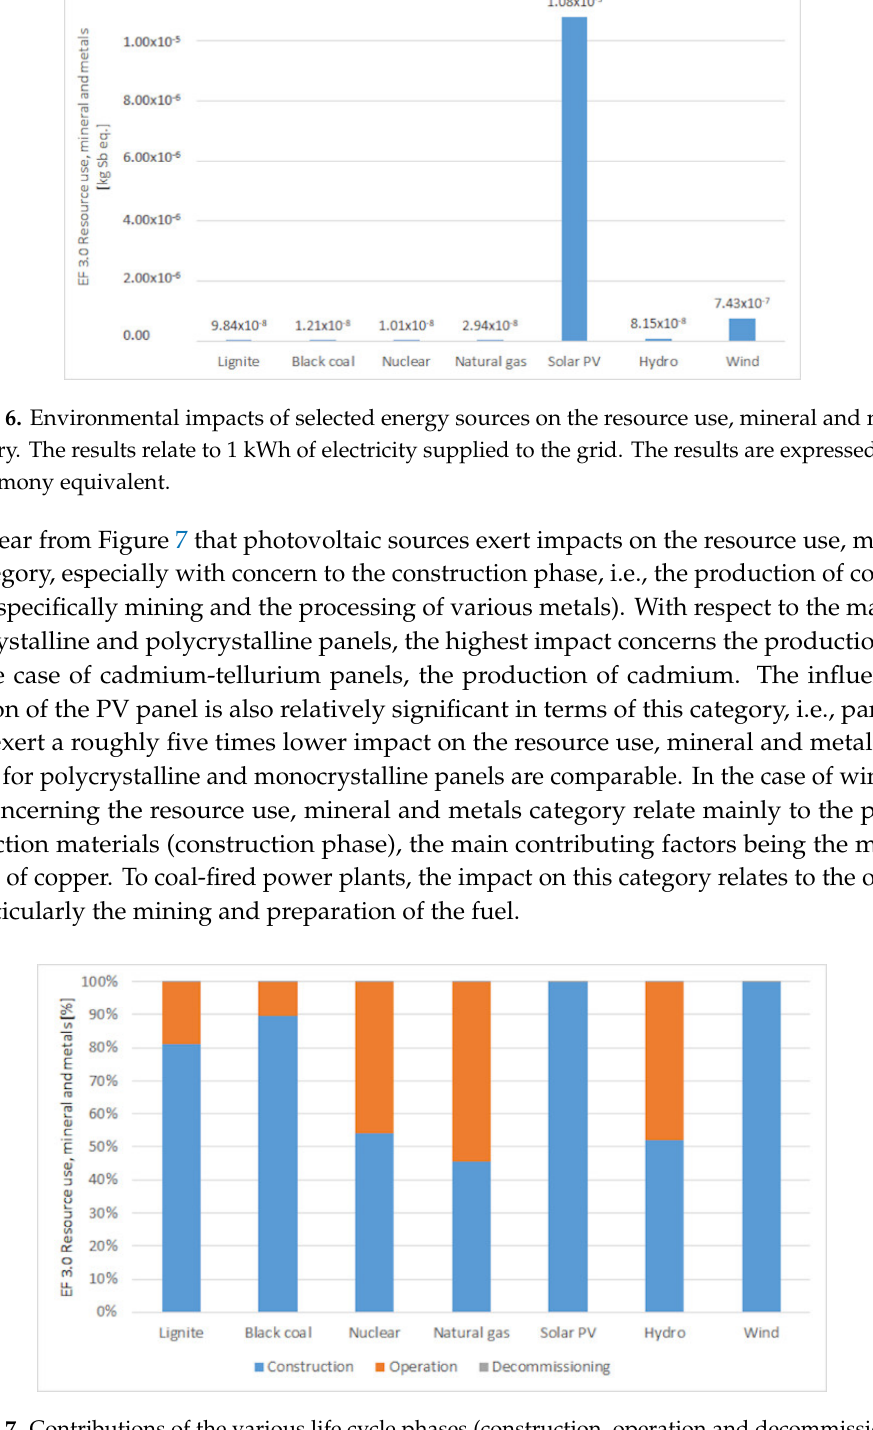
Figure 7. Contributions of the various life cycle phases (construction, operation and decommissioning) of electricity sources to the resource use, minerals and metals category. Environmental benefits